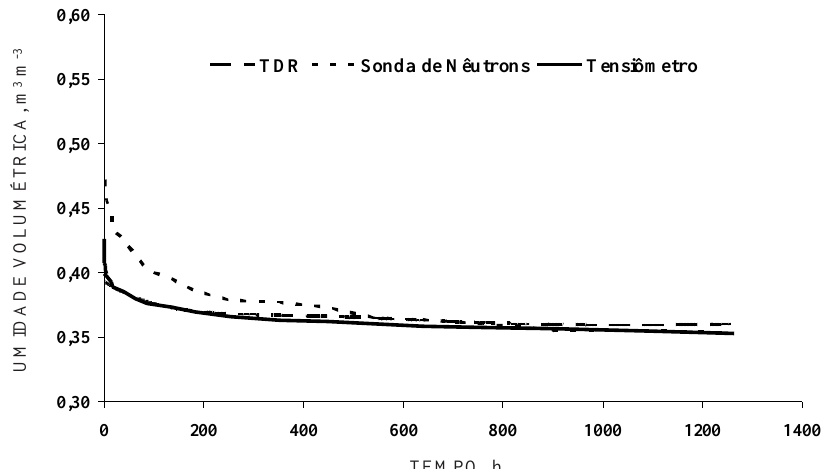
Figura 2. Variação da umidade volumétrica com o tempo para o tensiômetro, sonda de nêutrons e TDR, para a profundidade de 1,00